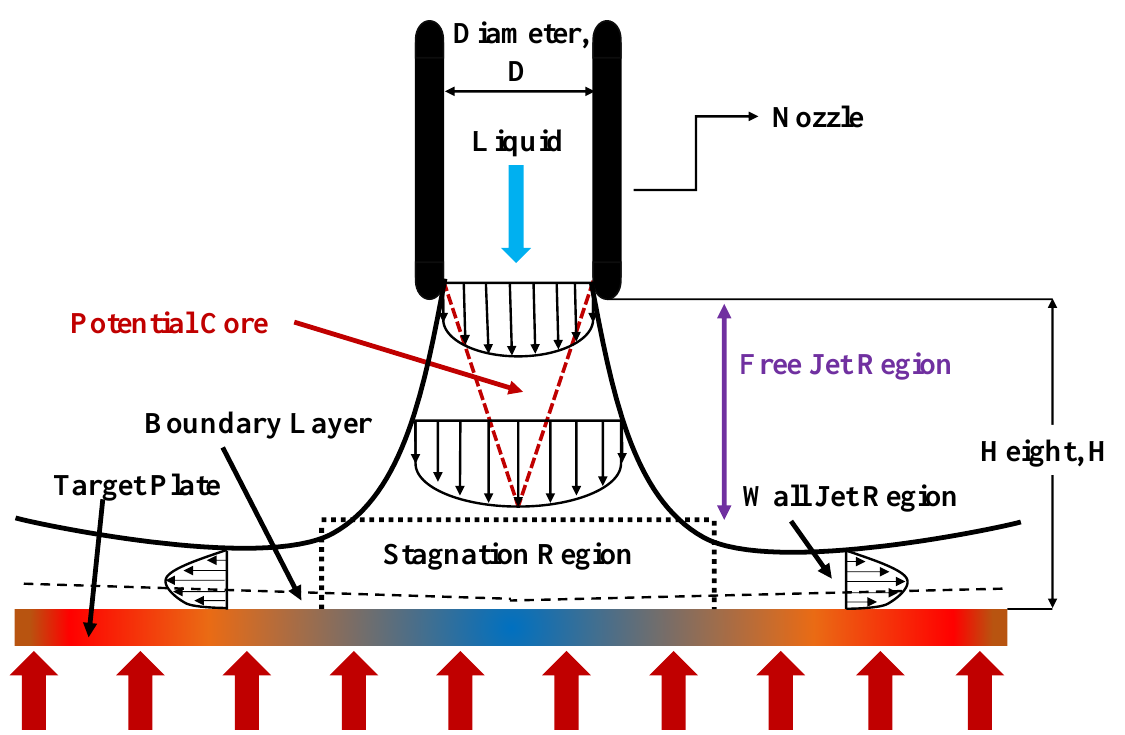
Figure 5. Flow structure of free surface jet. “Reprinted with permission from Ref [49]. Copyright 2022 MDPI ”.